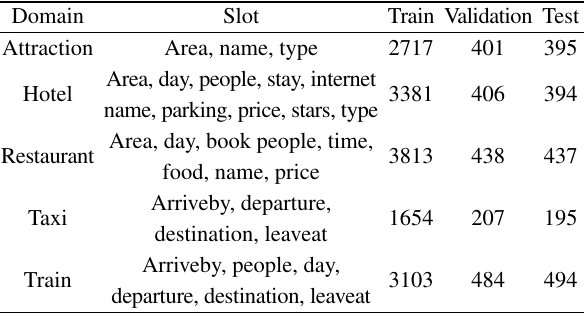
Table 2 Dataset statistics of